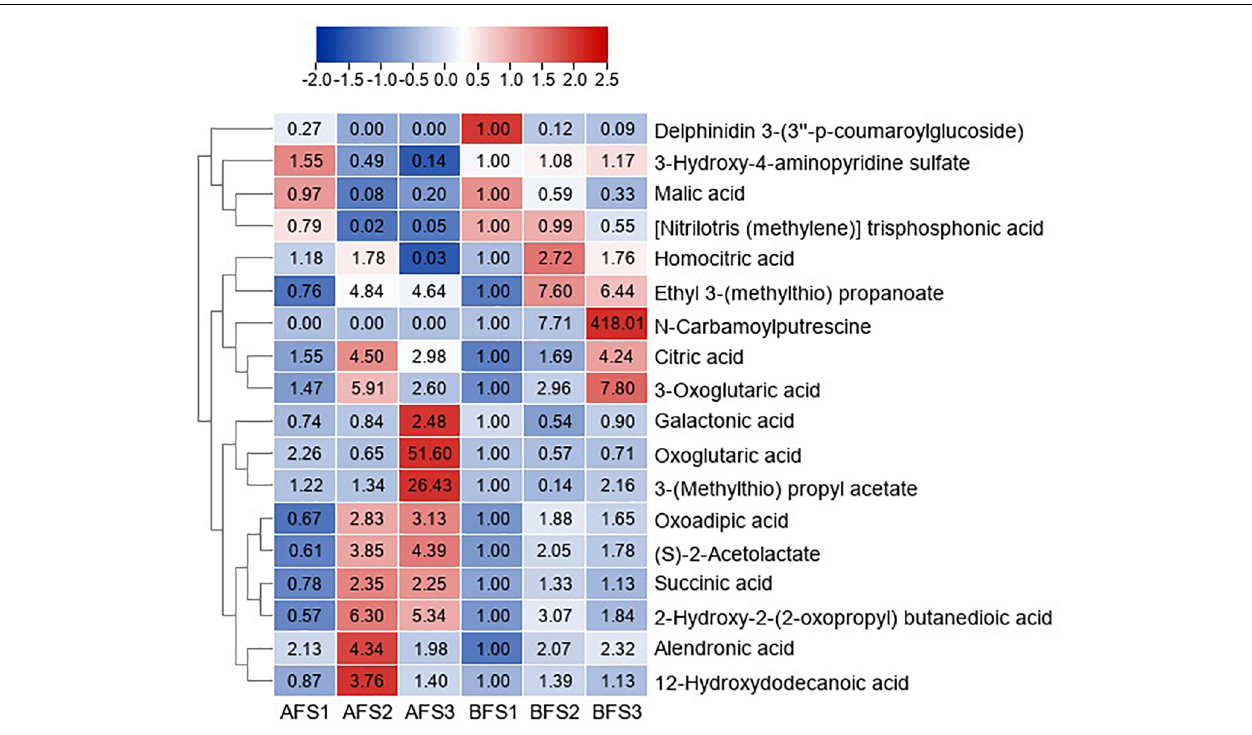
FIGURE 3 | Heatmap of the DAMs of organic acids during three fruit developmental stages of oriental melon cultivars A and B. The three “A” fruit development stages are AFS1, AFS2, and AFS3, and three “B” fruit development stages are BFS1, BFS2, and BFS3, respectively. DAMs are selected based on VIP > 1 and p < 0.05 in any of the comparison groups in the fruits. The FC values are displayed in the heatmap, which used the data of BFS1 as the calibrator.